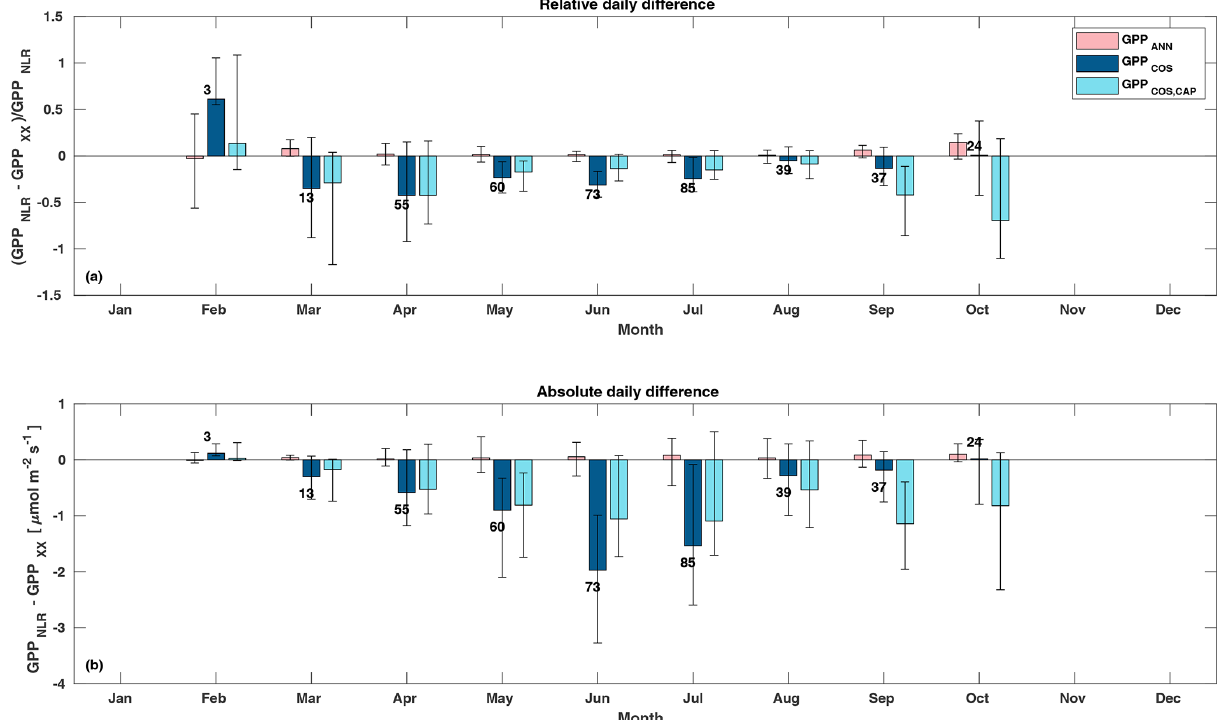
Figure 5. Relative (a) and absolute (b) difference of daily GPP ANN (pink), GPP COS,PAR (dark blue), and GPP COS,CAP (light blue) to GPP NLR in different months, averaged over the whole measurement period 2013–2017. Bars represent the median difference, and whiskers show the 25th and 75th percentiles. Numbers on top of the bars indicate how many daily flux data points have been used for calculating the medians. Median differences have been calculated using the same number of data points for each method in each